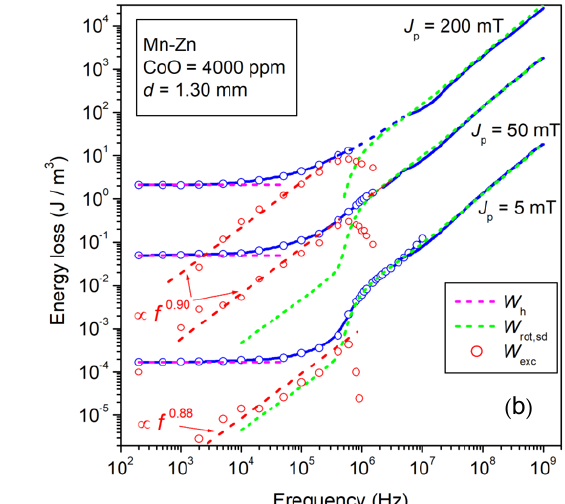
(cid:0) (cid:1) = (cid:0) (cid:1) + (cid:0) (cid:1) J p , f W h J p W r J p , f